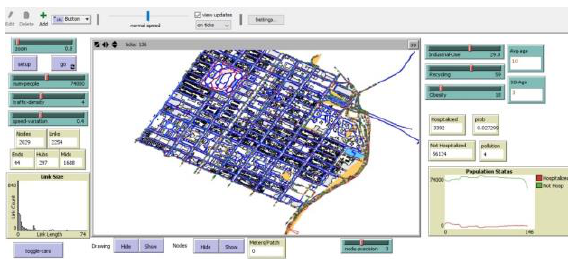
Figure 6: interface of the East Harlem asthma hospitalizations agent-based model.